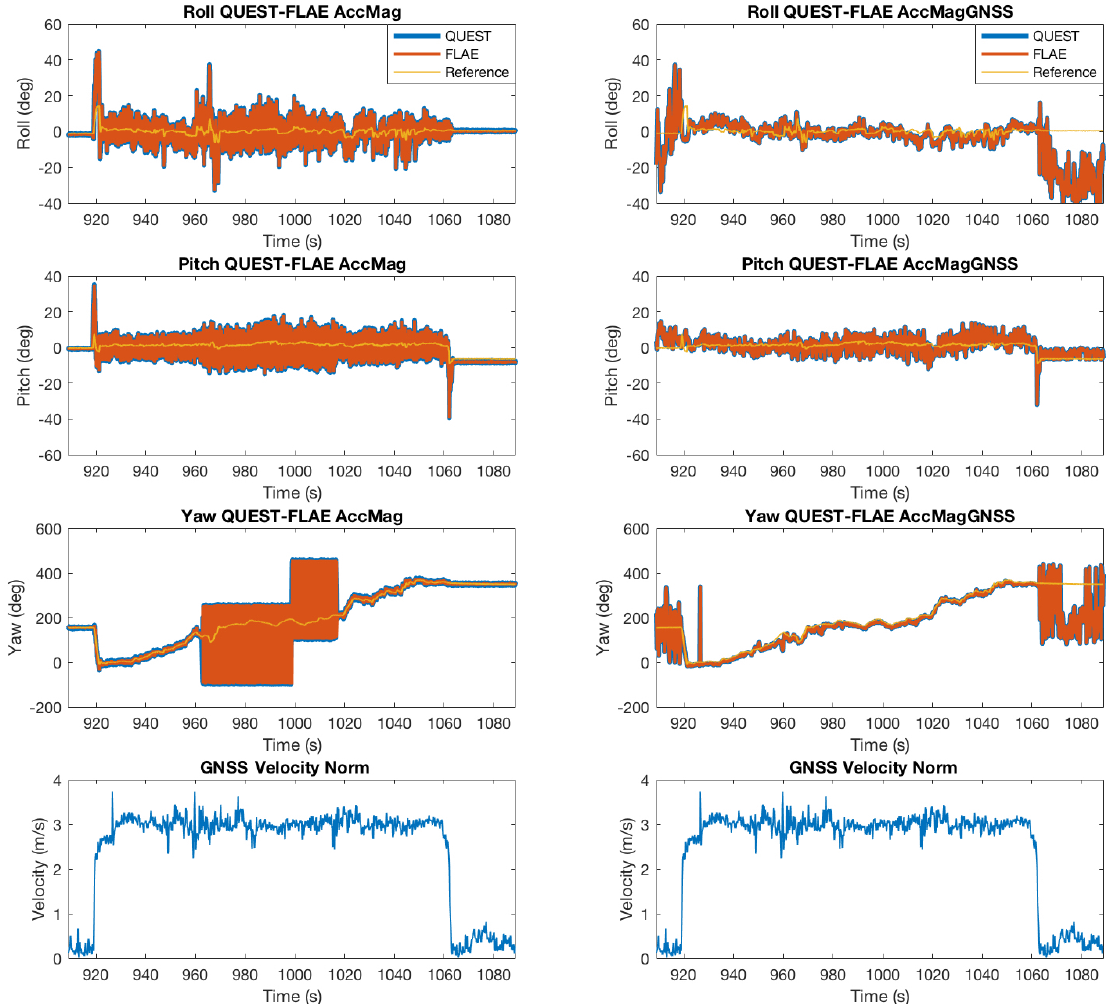
Figure 8. Attitude determination from the accelerometer, magnetometer and velocity output of the GNSS receiver, by means of QUEST and